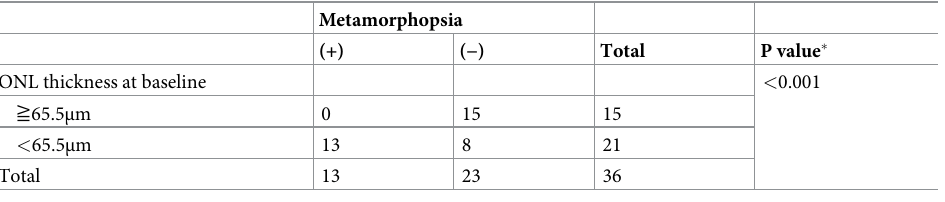
Table 7. Association between outer nuclear layer thickness at baseline and the presence of metamorphopsia at 12